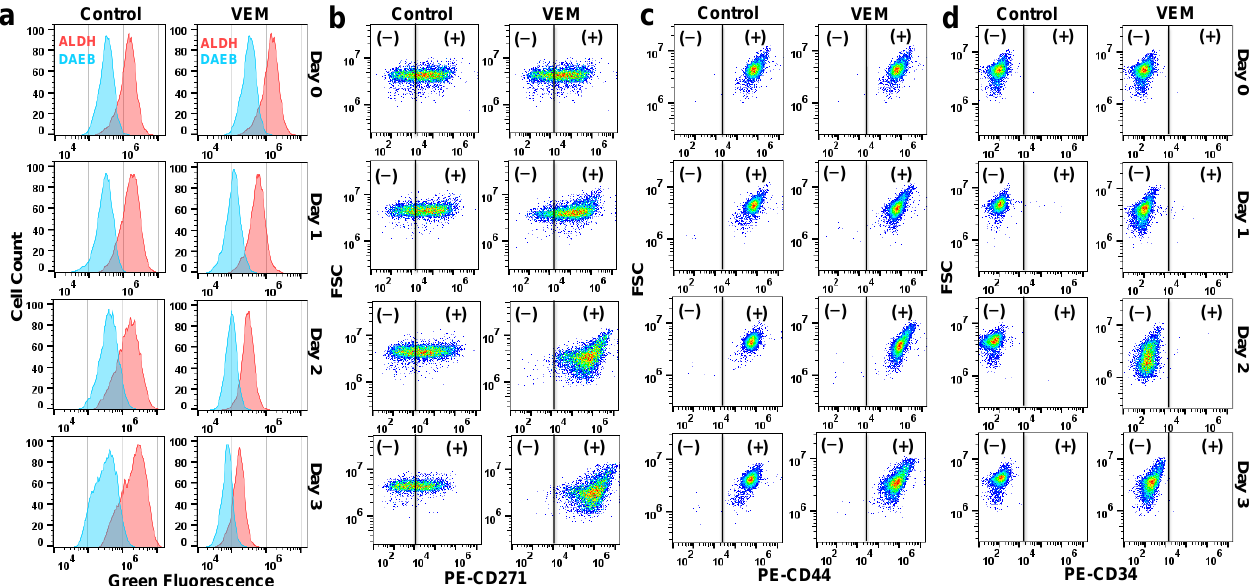
Figure 2. Expression of CSC markers in persister cells. ( a ) A375 cells were treated with VEM or left untreated for 3 days. At indicated time points, the ALDH activity of the cells (red) was assessed with the ALDEFLUOR assay. Cells treated with ALDH inhibitor 4-(dimethylamino) benzaldehyde (DAEB), highlighted in blue, were used as a negative control. ( b – d ) Expressions of CSC biomarkers (CD271, CD44, and CD34) were measured with their respective phycoerythrin (PE)-conjugated antibodies. Cells treated with their isotype controls were used to determine CSC-negative ( − ) and CSC-positive (+) cells. Live/dead staining was used to gate the live cells.